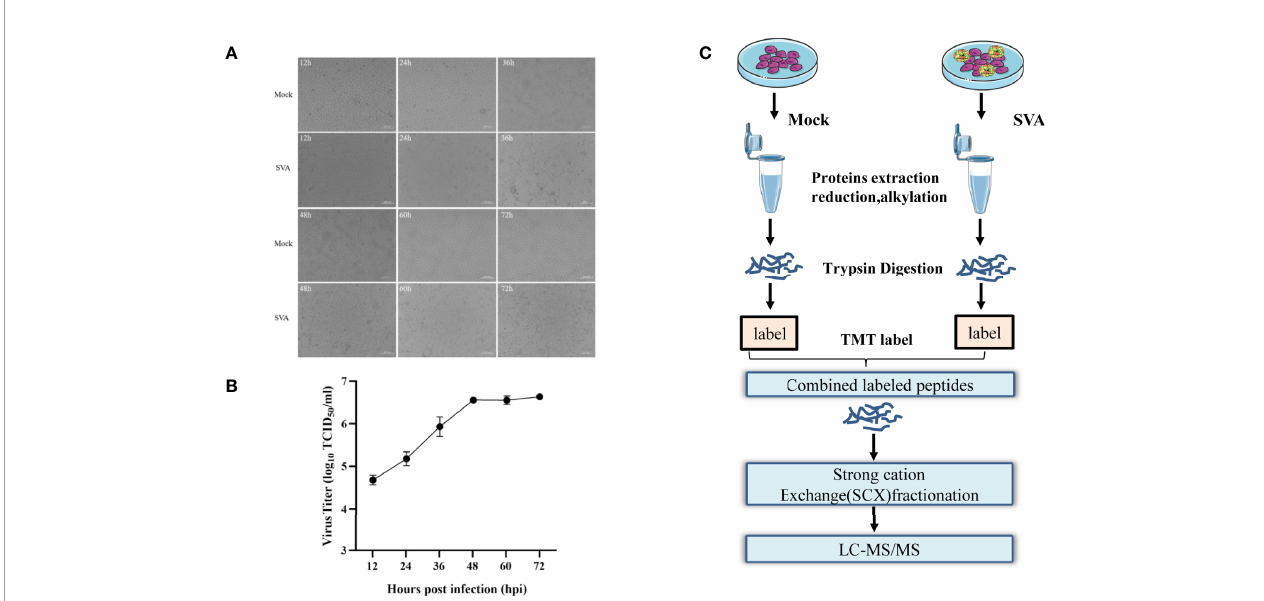
FIGURE 1 | Experimental design for identifying candidate novel cellular factors in mock- and SVA-infected PK-15 cells. (A) PK-15 cells were infected with 0.5 MOI of SVA for 12, 24, 36, 48, 60, or 72 h. The virus-induced CPE was observed and recorded by the microscope. (B) PK-15 cells were infected with 0.5 MOI of SVA for 12, 24, 36, 48, 60, or 72 h, and the viral titers were determined by the TCID 50 assay. (C) Schematic illustration of the sample preparation. PK-15 cells mock infected or infected by SVA at an MOI of 0.5 for 48 h were subjected to TMT-based proteomic